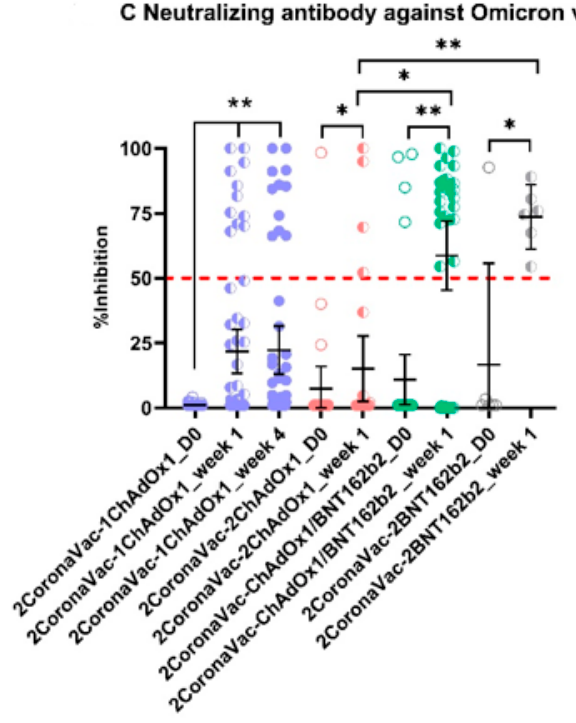
Figure 2. Neutralizing (NT) antibodies against SARS-CoV-2 Ancestral strain ( A ), Delta ( B ), and Omicron ( C ) VOCs. A “*” indicates significance of p < 0.05. A “**” indicates significance of p < 0.0001.